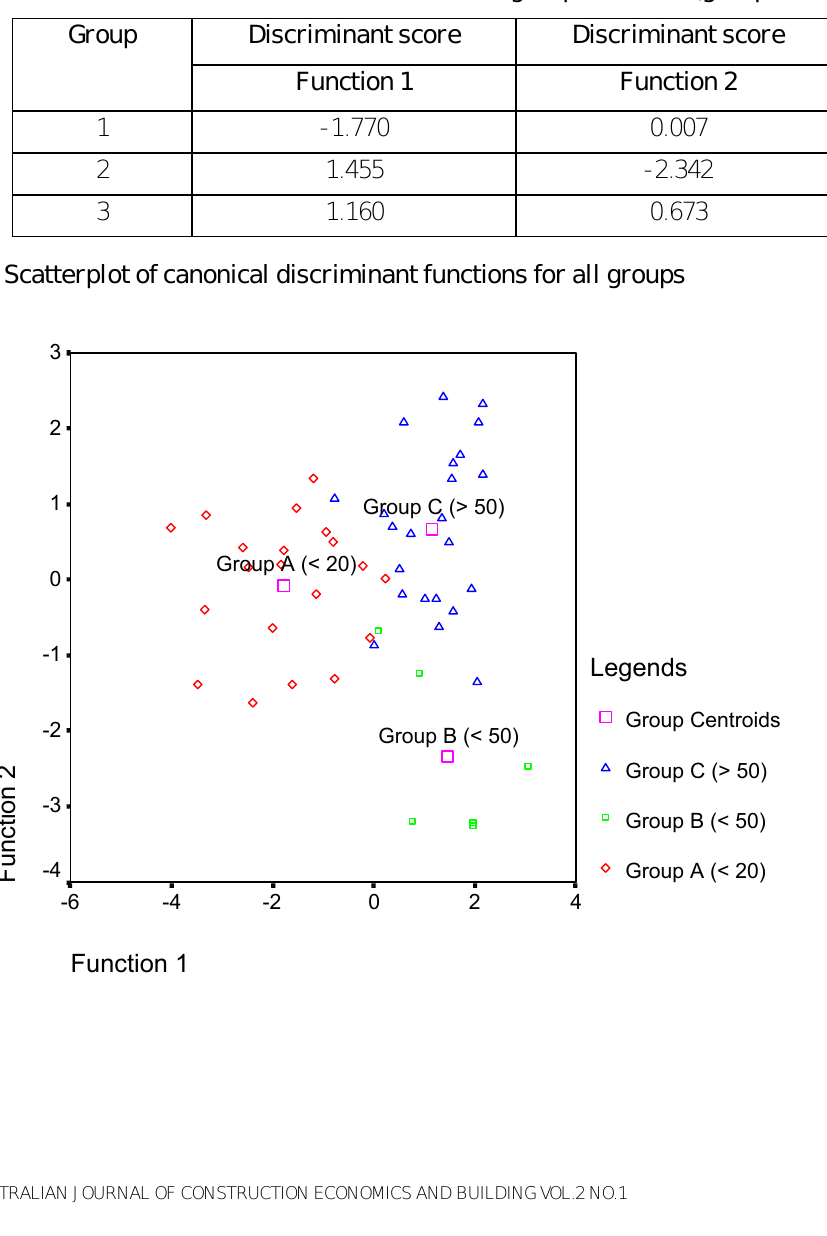
Table 9: Canonical discriminant functions evaluated at group centroids (group means)